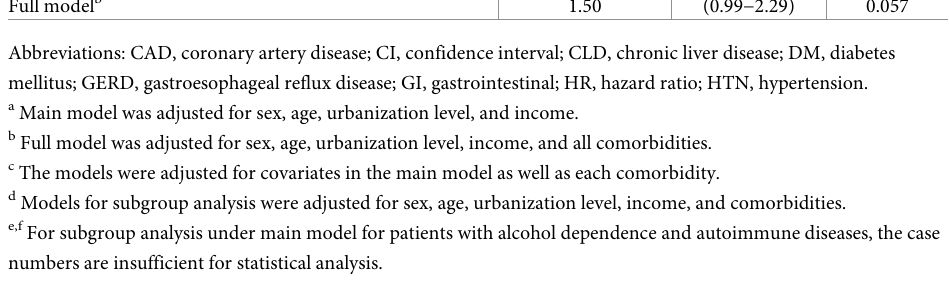
Table 3 reveals the results of Cox proportional hazard regression analysis, in which the epiglot- titis risks of the COPD and matched cohorts were compared. After sex, age, region of resi- dence, and monthly income level were adjusted for, the epiglottitis risk was found to